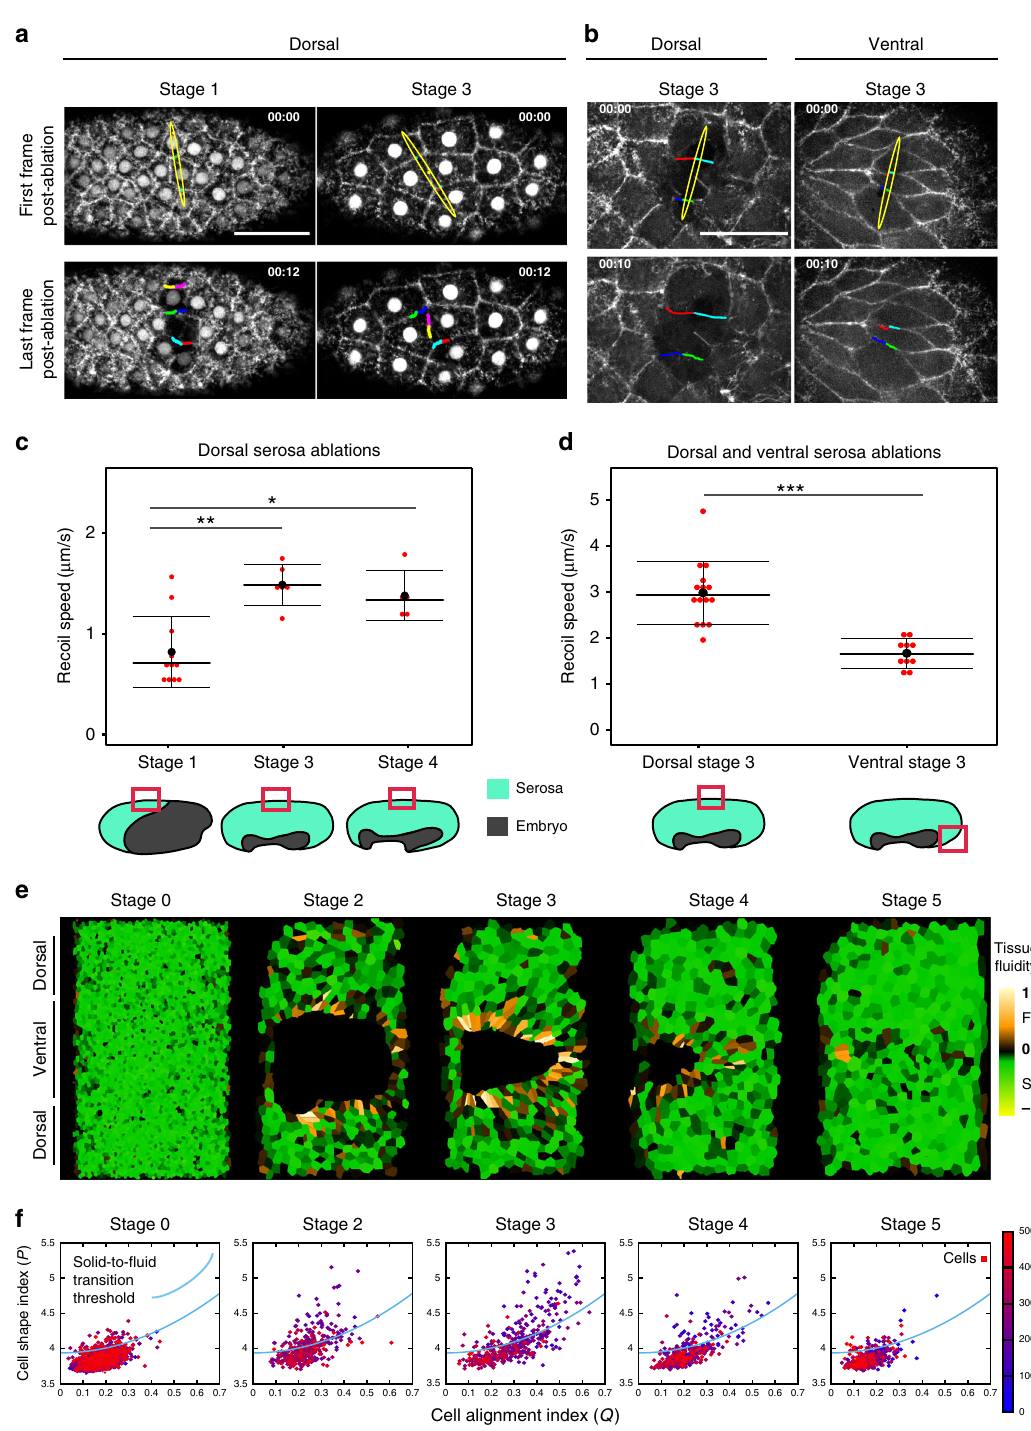
boundary stretched around the posterior pole. It peaked during serosa window closure and at this stage appeared as a contiguous supra-cellular cable (Fig. 4b and Supplementary Fig. 6A – C). The actomyosin cable lined the rim of the serosa window and underwent shape transformations from triangular to circular during closure (Fig. 4c and Supplementary Figs. 6B and 7A). The cable formed at the boundary of the serosa – embryonic (pro- spective amnion) region and the serosal cells forming the cable often appeared bent inwards over the window rim ( Supplemen- tary Fig. 7). By segmenting and measuring the length of the cable